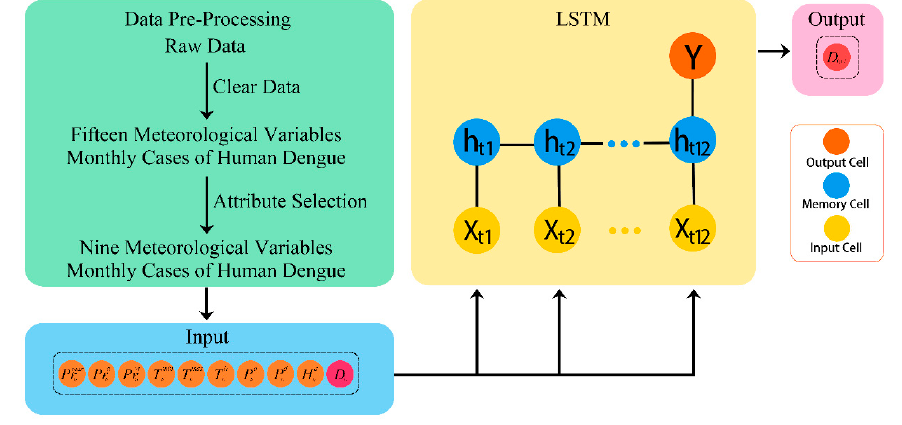
Figure 3. The architecture of the dengue forecast model using the LSTM network.